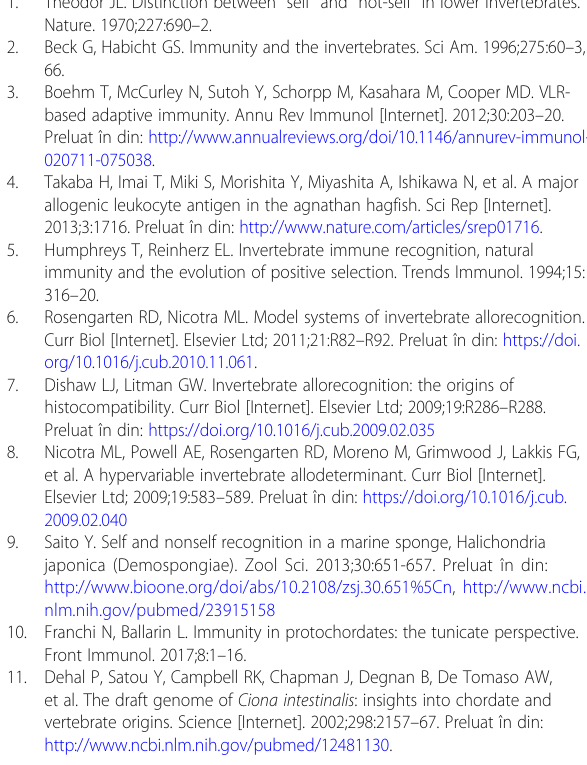
Additional file 1: Figure S1. N ′ terminal sequence of each spot of self- marker candidate proteins. Spot no. 3, 4, 8 and 10 were excised from the membrane and sequenced by automated Edman degradation at the Instrumental Analysis Division, Creative Research Institution of Hokkaido University. Additional file 2: Figure S2. Genomic southern hybridization of 100-kDa proteins crossed by mAb11B16B10. H. roretzi genome DNAs were digested with Bam HI or Pst I and performed southern hybridization with HrSMLP1 probe. Additional file 3: Figure S3. PAS staining of self-marker candidate proteins. The membrane extract of H. roretzi hemocyte were performed 2D-PAGE stained by CBB staining (left panel) and stained by peroxidase oxidation and Periodic acid – Schiff stain (right panel). Additional file 4: Figure S4. Polymorphism analysis in HrSMLP1. HrSMLP1 transcripts in 24 individuals (Hr.1 – 24) were sequenced and compared. The red letters show the substitution sites and amino acids in comparison with Hr.1 Accession numbers: Hr.1 (LC488798), Hr.2